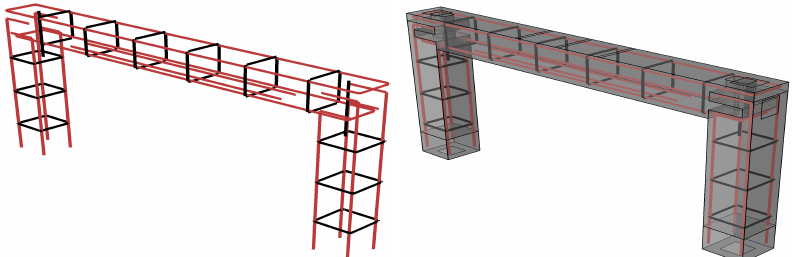
Figure 7. F2, Rebar layout and geometrical dimensions.